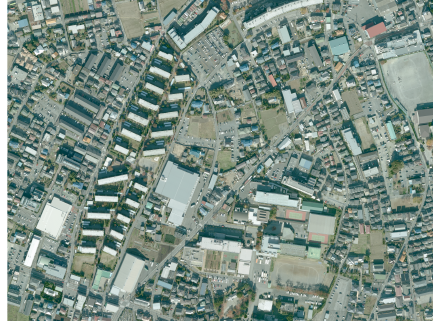
Figure 2. Aerial images in Saitama District year 2012